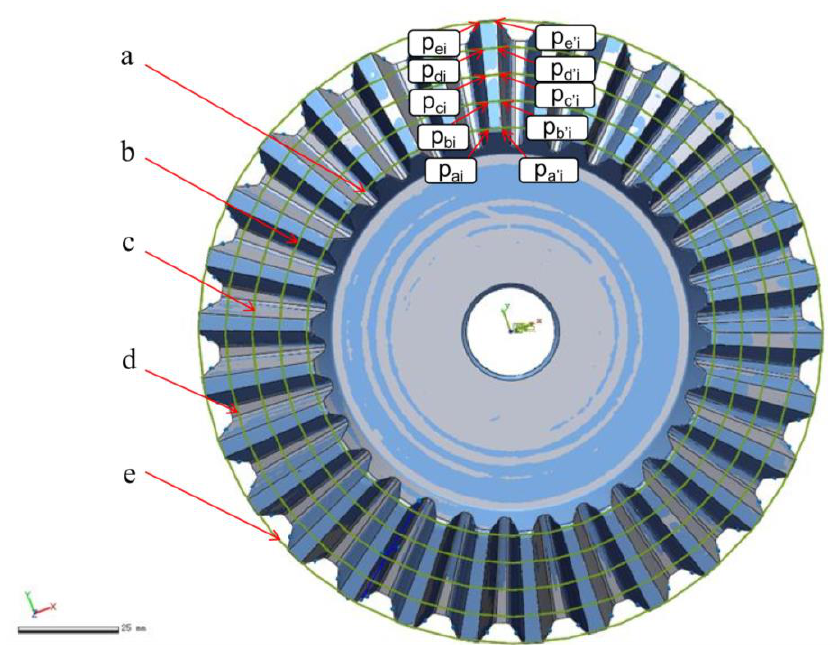
Figure 12. Validation of the proposed coaxial multi-ring measurement method.